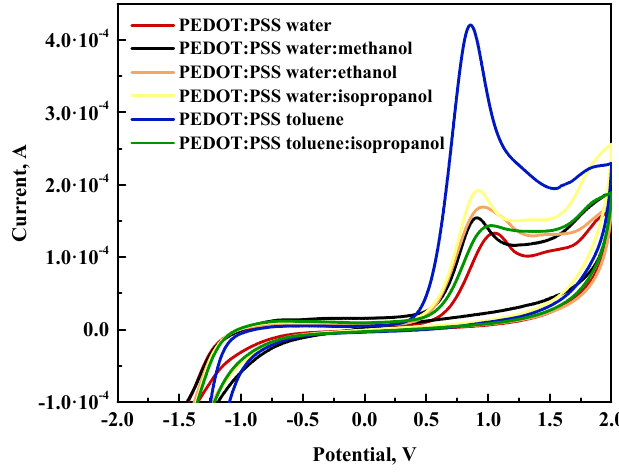
Figure 6. Comparative summary of CV curves for all tested PEDOT:PSS layers.